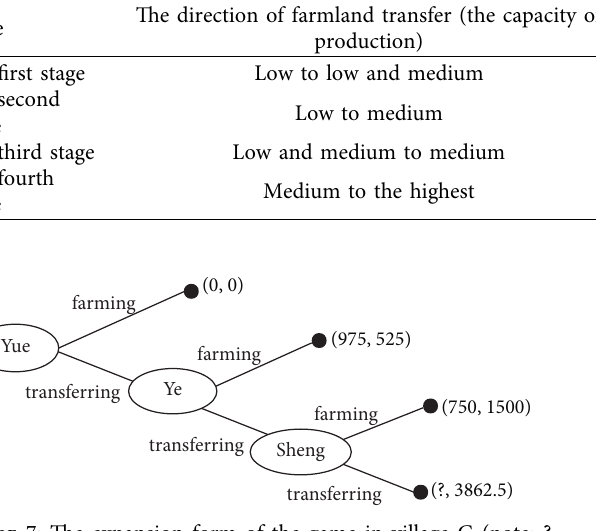
Figure 7: The expansion form of the game in village G (note: ? means that the benefit of Zhang, an industrial and commercial entity outside village G, is